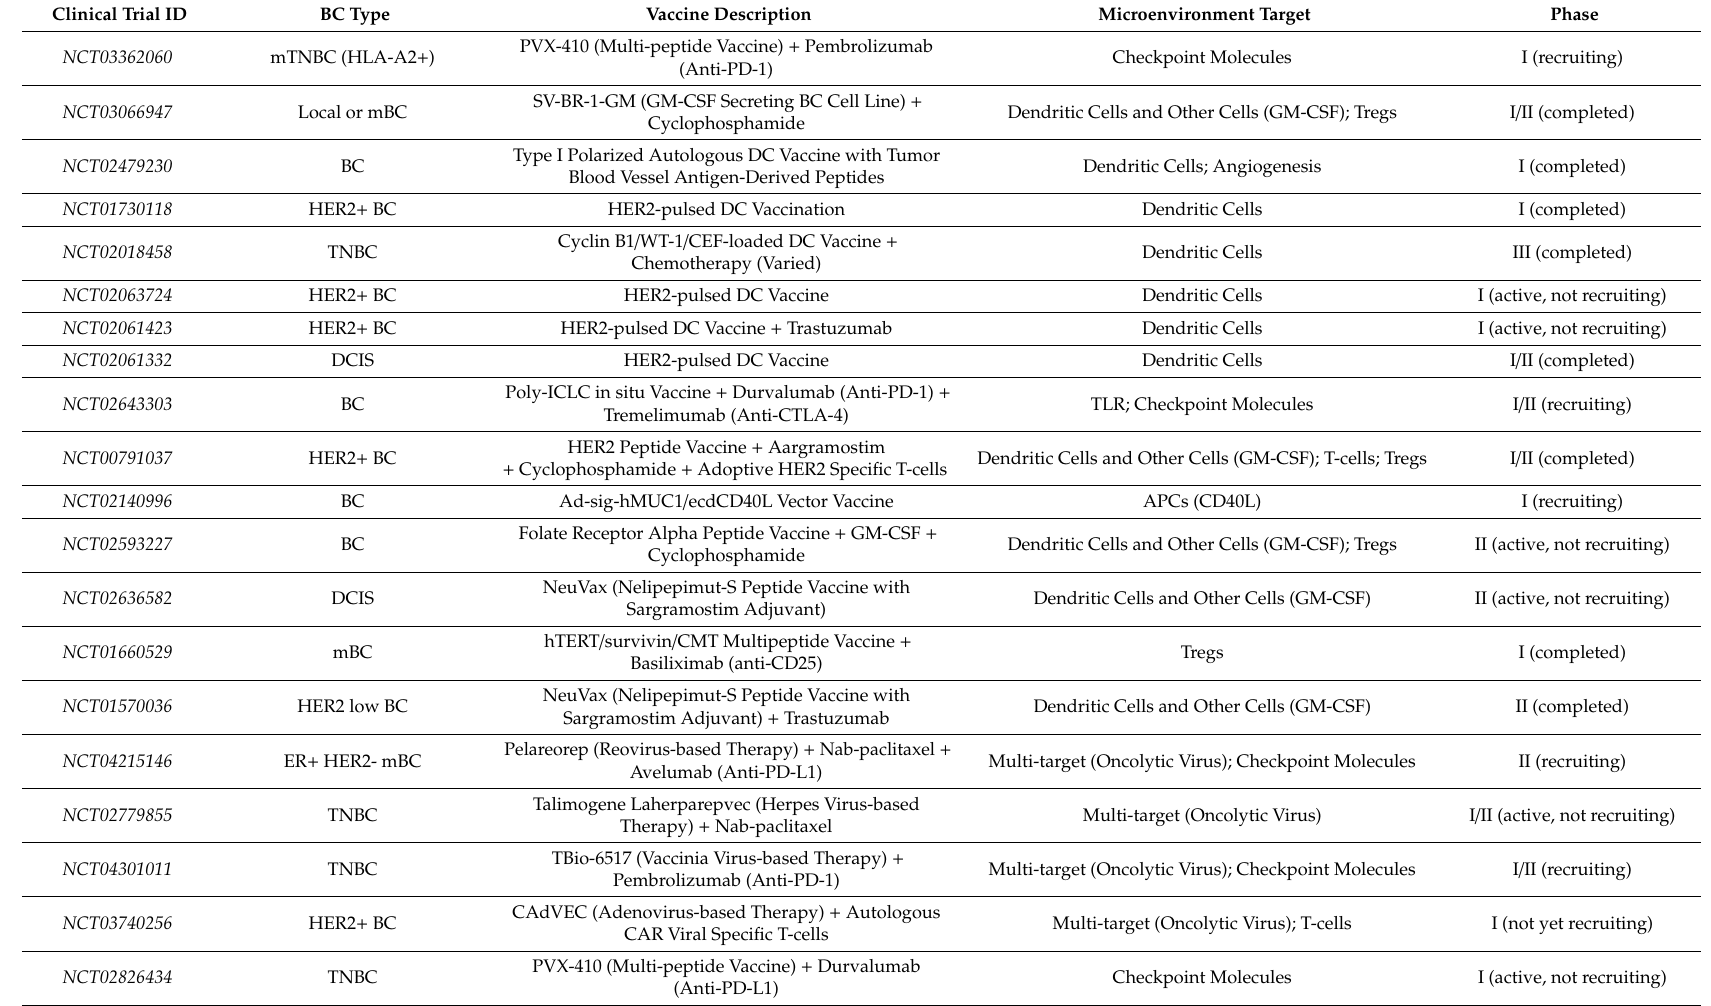
Table 2. BC Vaccine Clinical Trials that Target